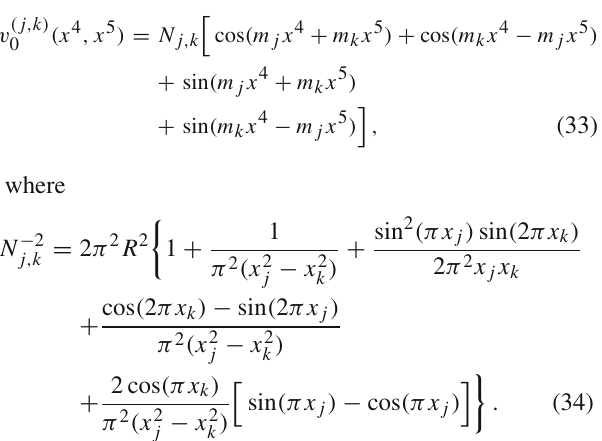
Fig. 4 Solutions of the transcendental equation (30) for different val- ues of δ A , when δ A = δ B , for the thin-brane model